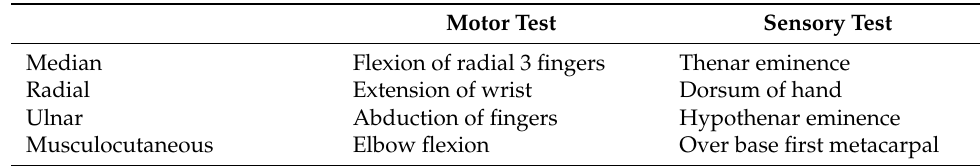
Table 1. Motor and sensory